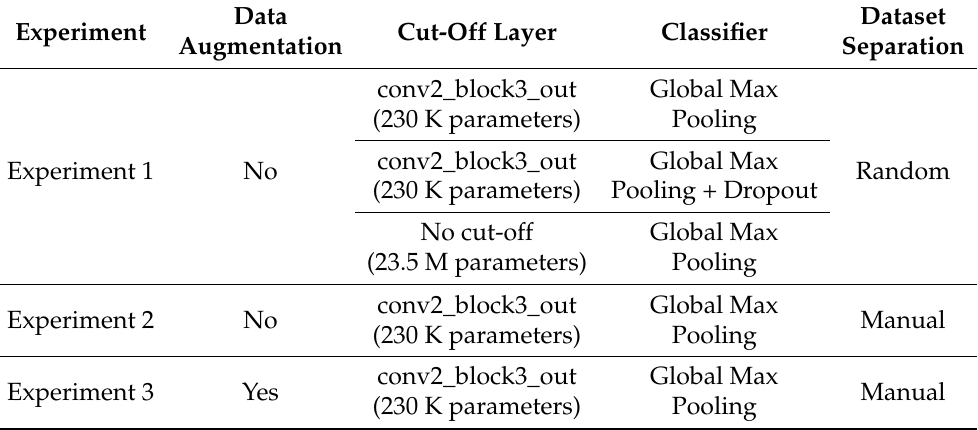
Table 1. The summary of three experiments classified according to the different